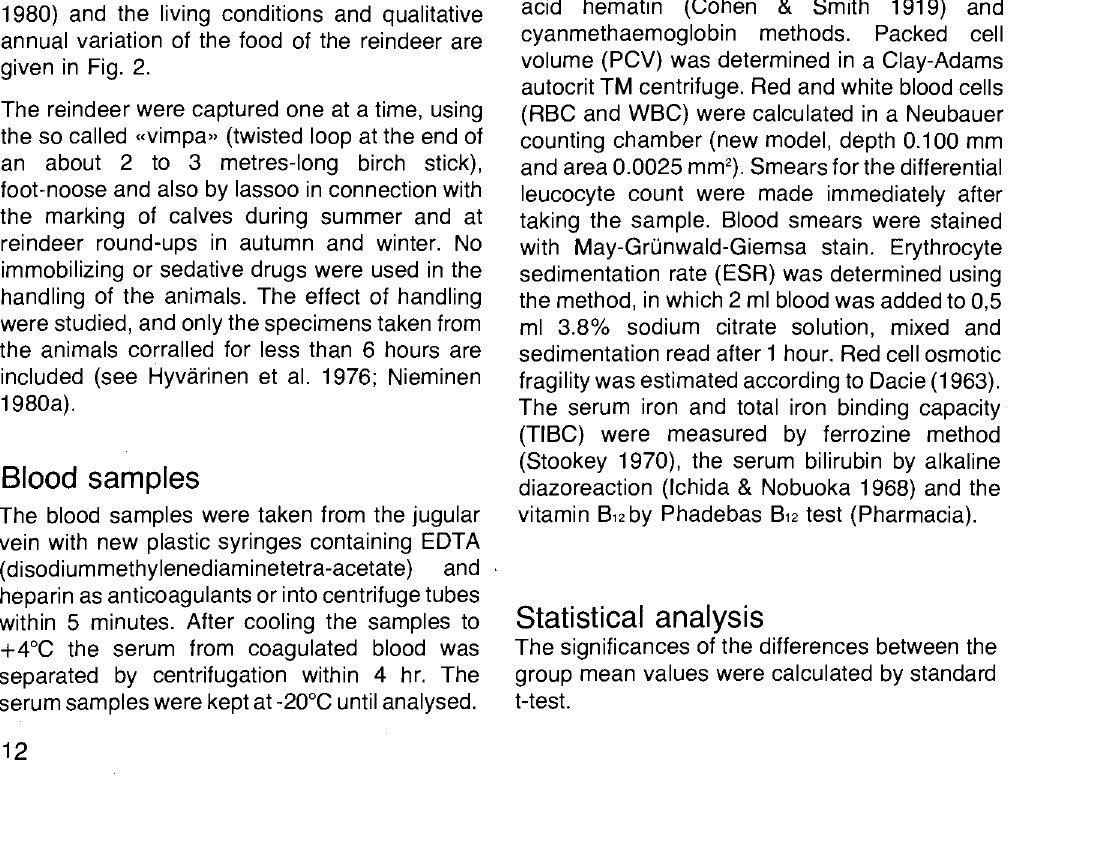
Fig. 1. Qualitative annual variation of the food of the reindeer (approximated diagram), and the monthly day lenght, mean air temperature and snow depth in Sodankylä (68°05'N, 27°11'E, altitude 246 m) in 1961-75 (Nieminen 1980a).